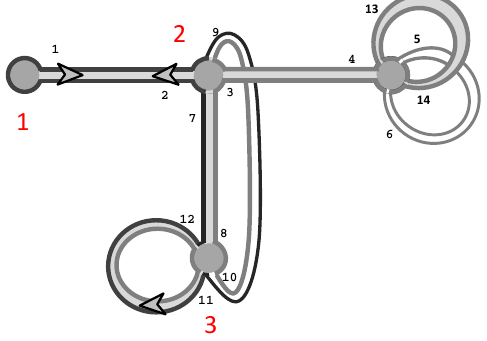
Figure 4 . The ribbon graph corresponding to figure 3. The three vertices with marked half edges correspond to the external electron lines and the labels 1 to 14 on the half edges are the same as the ones shown in figure